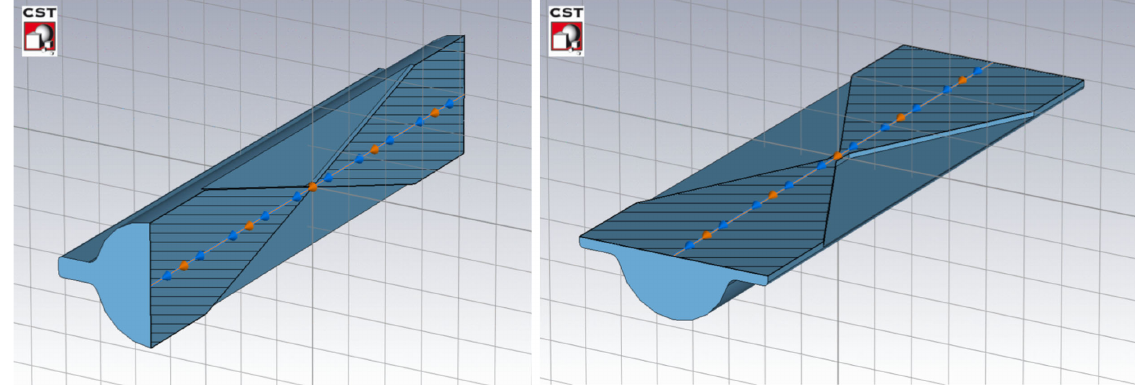
FIG. 16. CST perspective view of the vertical collimator (left side) and top view of the horizontal one (right side).